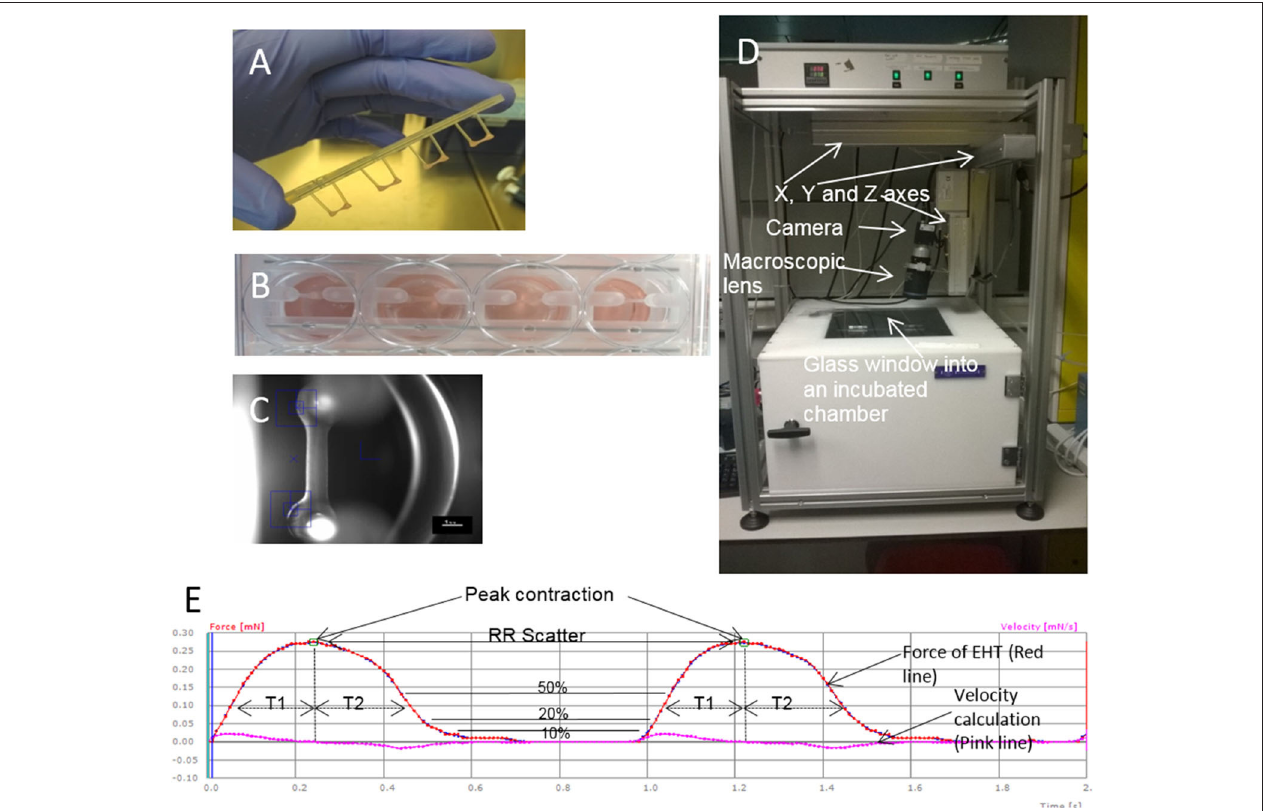
FIGURE 1 | EHTs and the white box. (A) Four EHTs attached to a silicone rack are shown, and (B) inside media in a 24 well-plate. (C) A contraction is recorded by the movement of the blue boxes which pick up the contrast difference between the EHT and the background. (D) A picture of the outside of the white box. (E) Contraction measurements on traces from the white box. An example of an EHT contracting for 2s is shown indicating how different parameters are calculated from contractions. Peak contraction is taken at the green boxes and RR scatter as seconds is calculated as time between the two boxes. Time to contraction (T1) is calculated at 10, 20, and 50% of the peak from the midline to the edge of the curve, and relaxation time (T2) is calculated in the same way. Contraction velocity and relaxation velocity are calculated as the derivative of the curve and shown by the pink line. Each small box on the Red and Pink lines shows a frame taken by the white box camera which runs at